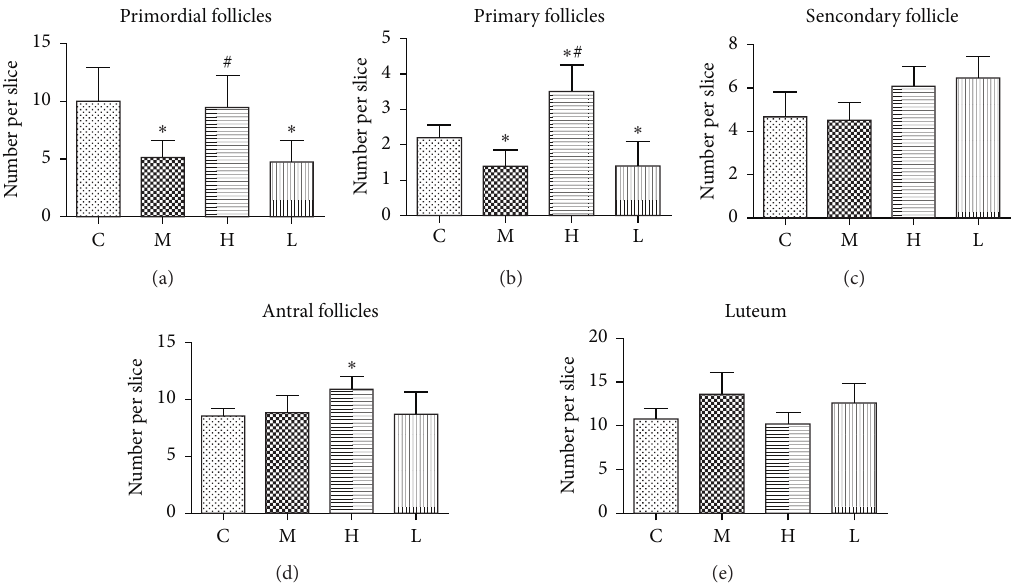
Figure 2: The number of follicles at different stages (a–d) and the number of corpus luteum (e) in the ovaries of rats in each group. ∗ : significant compared with group (C) p < 0.05; #: significant compared with group (M) p < 0 .